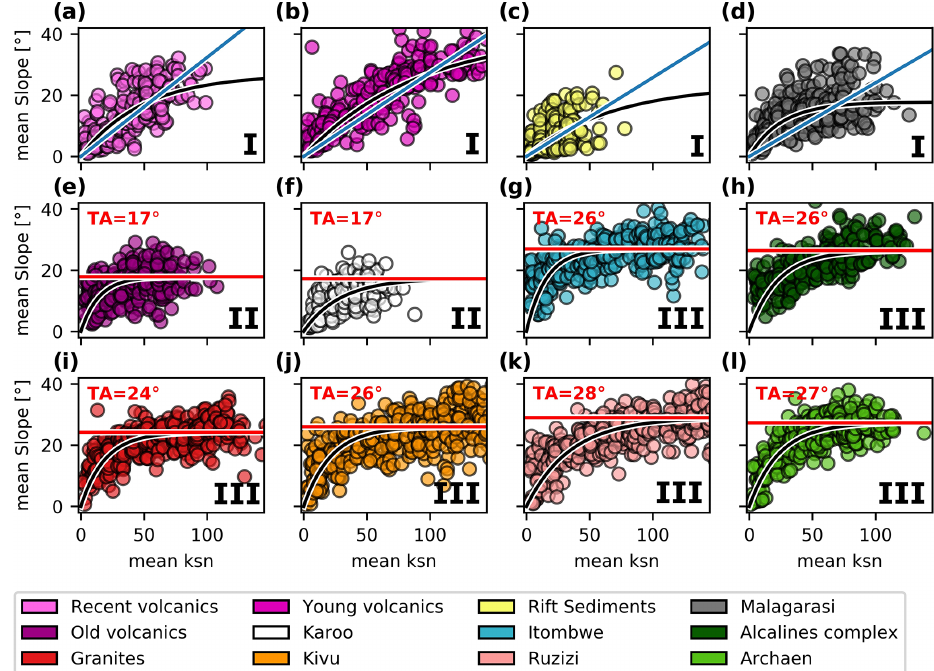
Figure 8. Threshold slope analysis for the different lithostratigraphical units in the NTK rift. Each point represents a first-order river catch- ment over which we averaged the slope gradient S and normalized river steepness index k sn . The black curves represent the S = f ( k sn ) relationship fitted to Eq. 2. (a) – (d) Category I: young lithostratigraphy for which no clear threshold angle is observed. (e) – (f) Category II: young lithostratigraphy with a low threshold angle of ca. 17 ◦ . (g) – (l) Category III: older rocks with higher observed threshold slopes of 24–28 ◦